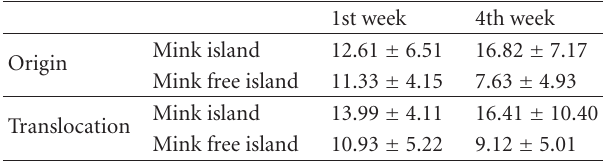
Table 2: Mean and SD of distances (in m) moved by voles between consecutive localisations during first week and fourth week after translocation depending on the island from which a vole originated (origin) and the island where a vole was released (translocation).